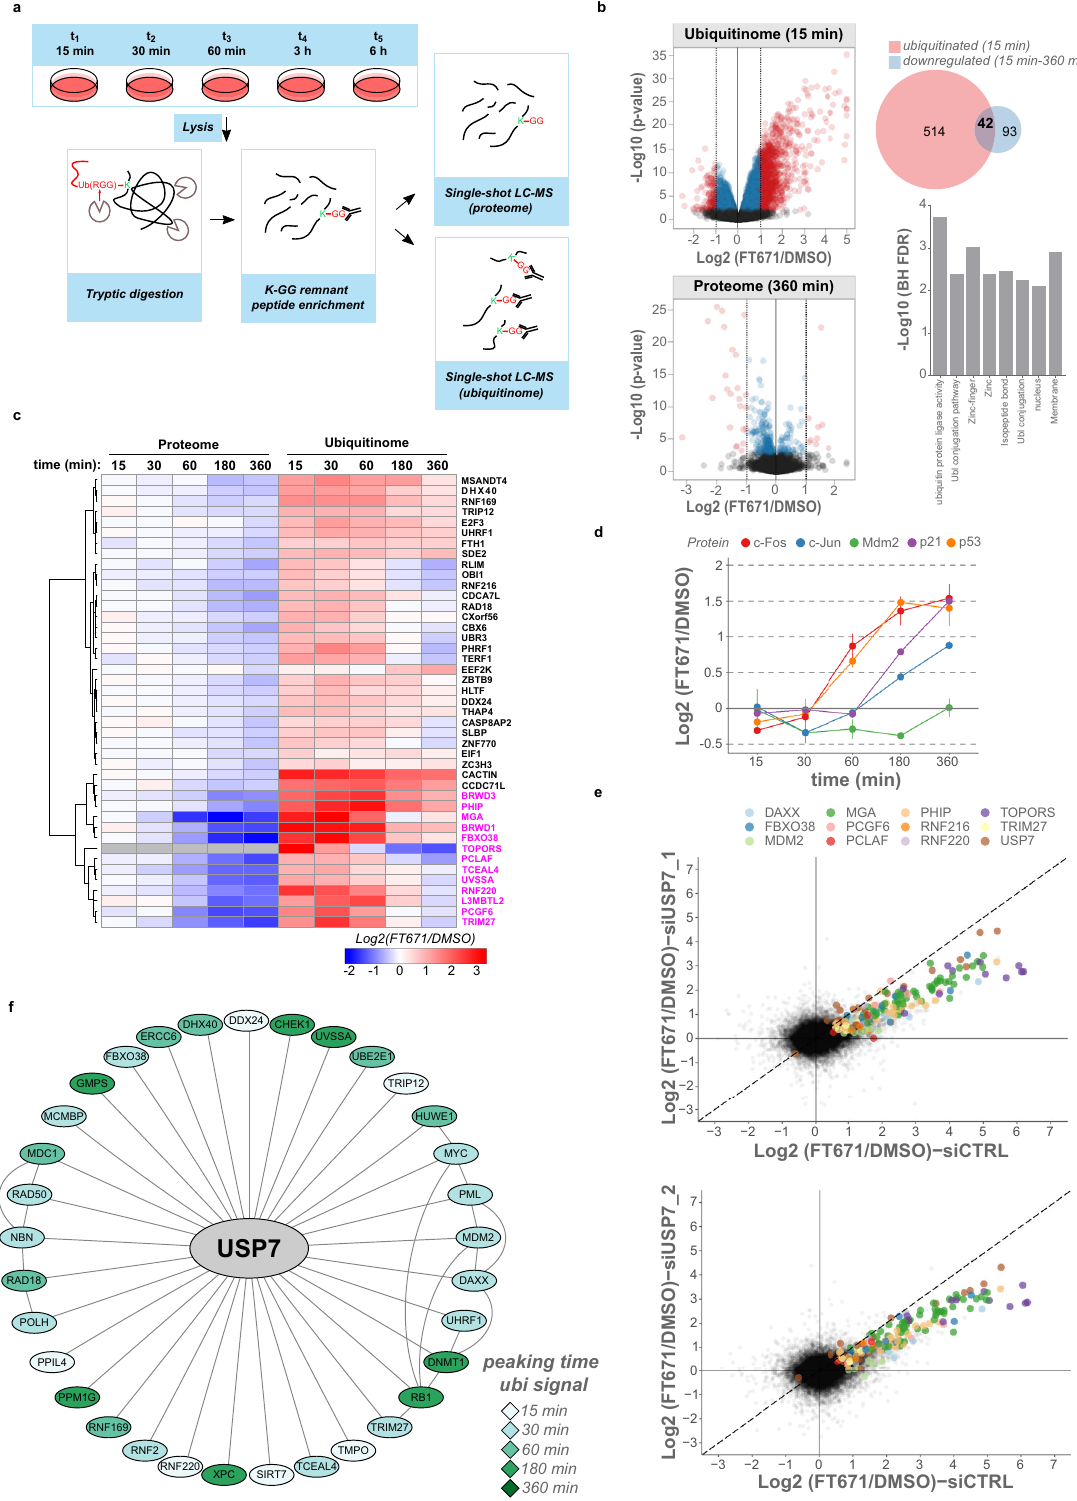
The strikingly high regulation of protein ubiquitination already early time points, we did not observe signi fi cant protein changes at 15 min of USP7 inhibition pointed to a rapidly regulated, except for the downregulation of the E3 SUMO/ubiquitin ligase complex signaling network. To further dissect which of the Topors at 10 min (Supplementary Fig. 6a). Topors was strongly upregulated ubiquitination sites are directly controlled by USP7, degraded also in our initial time-course experiment and was below we performed a high-resolution time-course experiment with detection limit already 15 min after USP7 inhibition (Fig. 4c). In much faster sampling (at 2, 6 and 10 min), again quantifying both contrast, even at 2 min of FT671 treatment, we found 927 the ubiquitinome and the proteome in single-shot mode. At these ubiquitinated peptides that were signi fi cantly and more than NATURE COMMUNICATIONS| (2021) 12:5399